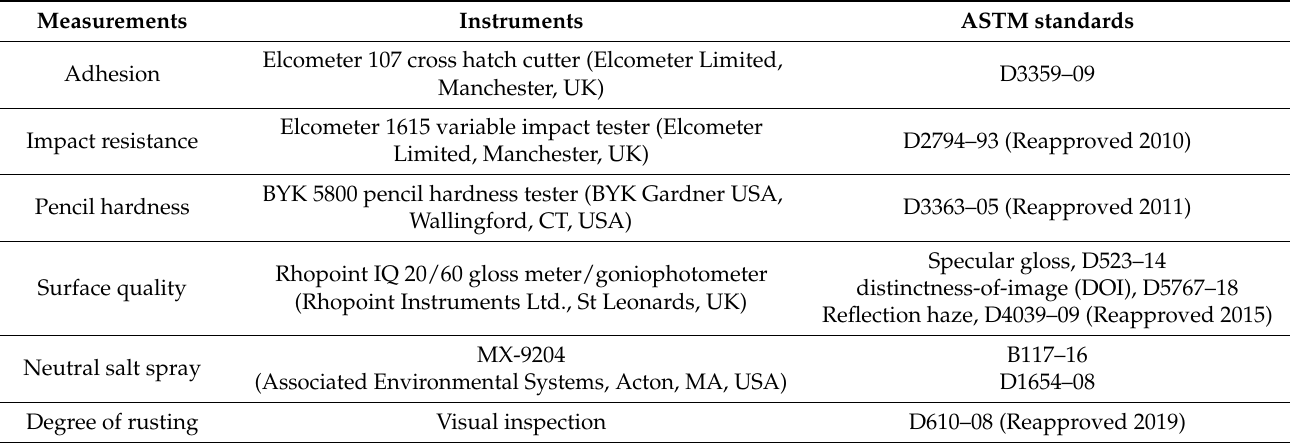
Table 3. Standard test methods and instruments for coating performance